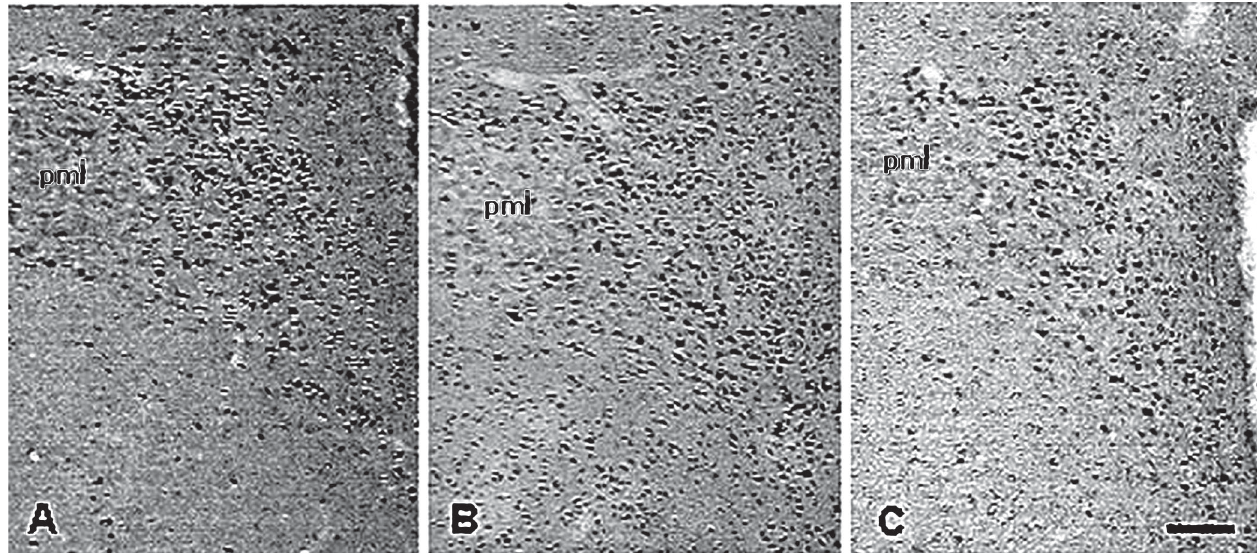
Figure 3. Photomicrograph illustrating the effect of repeated immobilization on c-Fos expression induced by immobilization in the paraventricular hypothalamic nucleus. A , Rats were left undisturbed in their home cages for 6 days; B , rats were submitted to 6 days of repeated immobilization (1 h/ day); C , rats were submitted to 13 days of repeated immobilization (2 h/day). pml = posterior magnocellular part, lateral zone. Magnification bar: ~200 µm. Note a significant reduction in the number of c-Fos-immunoreactive cells in B and C (habituated groups) in relation to A (acute